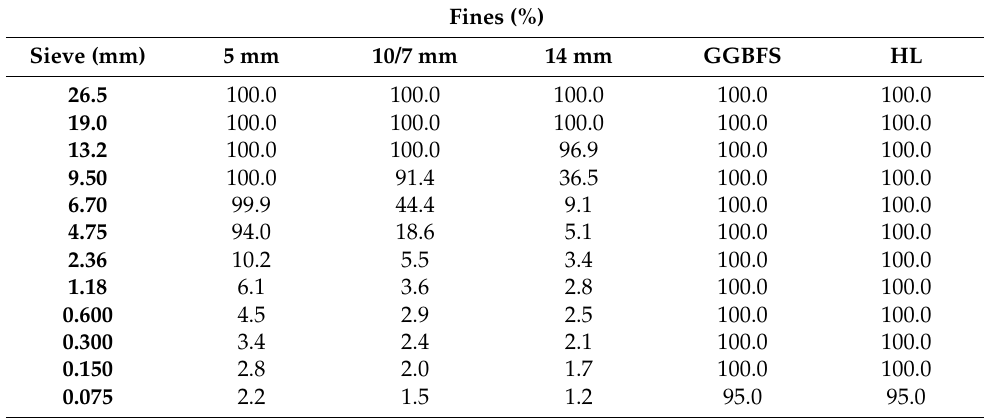
Table 1. PSD of the